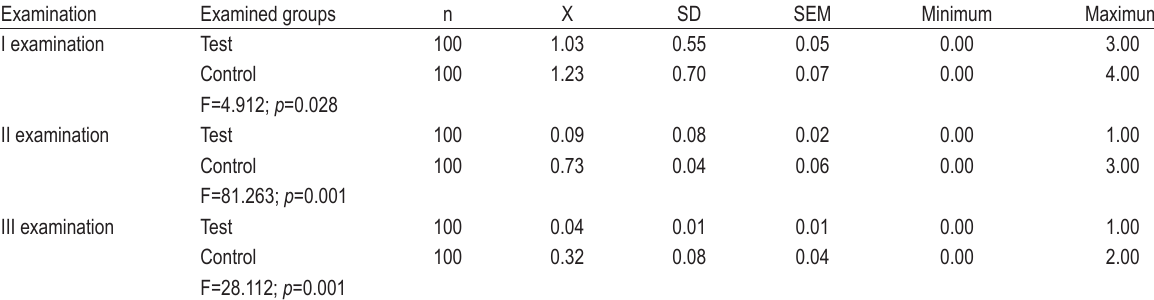
TABLE 3. Analysis of the ability of to carry out personal care in both studied